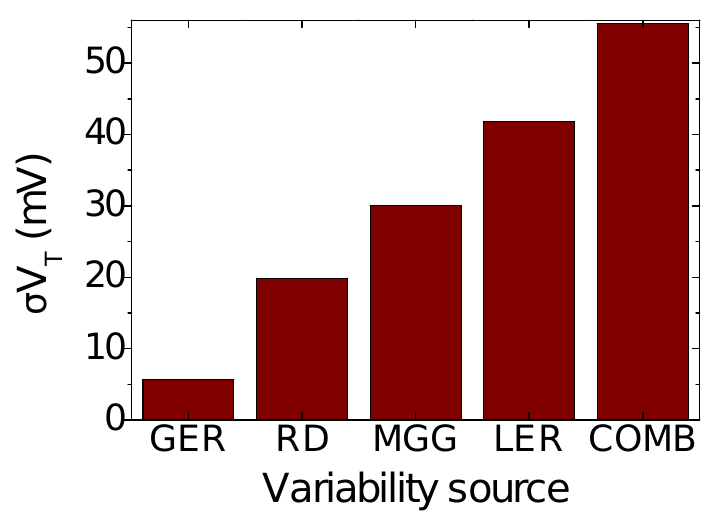
Figure 5. Comparison of the threshold voltage standard deviation due to four different variability sources (GER, RD, MGG and LER) and their combined effect (COMB) in the 10 nm GAA-NW FET.